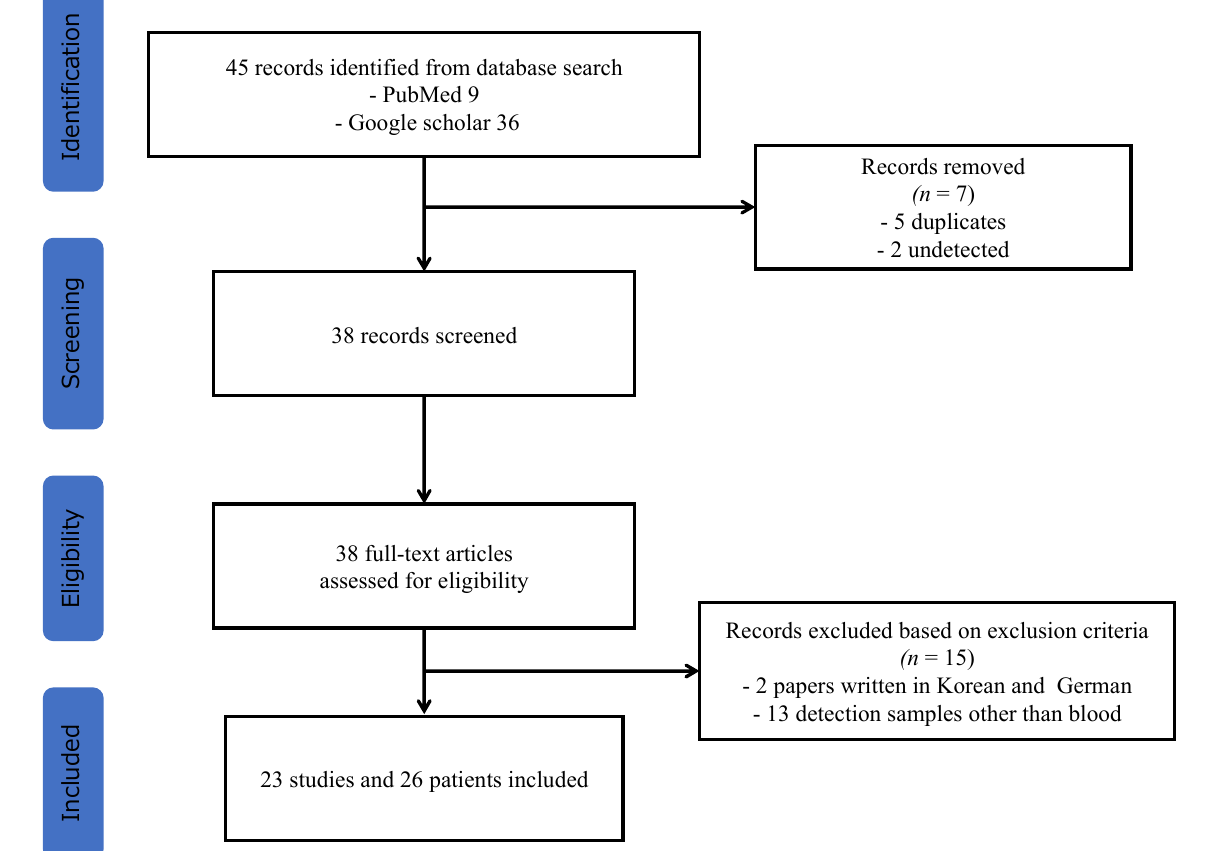
Figure 1. Flowchart of the study selection process for the systematic review.